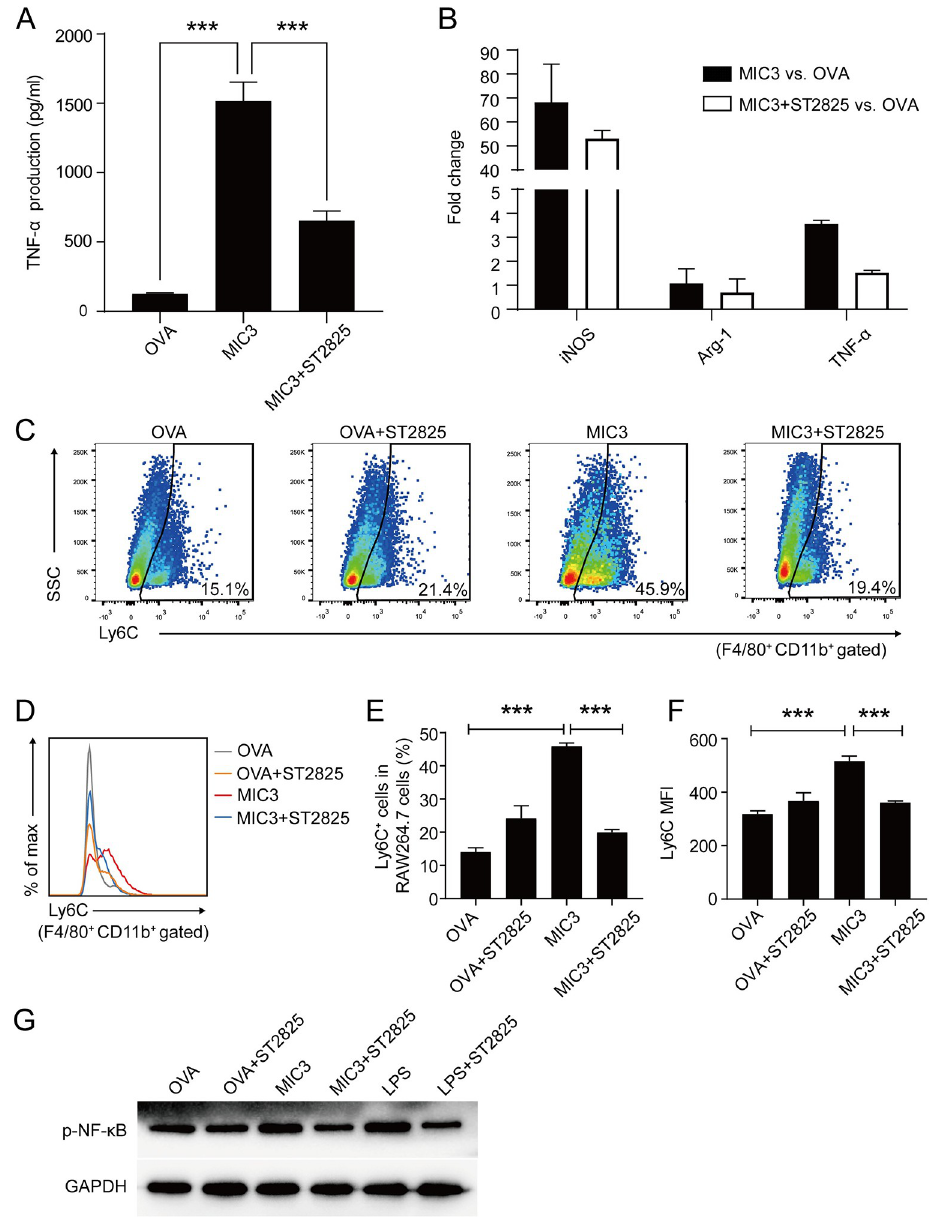
Fig 3. The role of MyD88 in inflammatory immune response induced by MIC3 in RAW264.7 cells. (A) The levels of TNF- α secreted by RAW264.7 cells after 24 h-treatment of 4 μ g/ml MIC3 and OVA. To inhibit the activity of MyD88, RAW264.7 cells in group MIC3+ST2825 were preincubated with 20 μ g/ml MyD88 inhibitor ST2825 for 3 h. The secretion of TNF- α was analyzed by ELISA. Each bar indicates the mean value ± S.D. (n = 4 independent replicates). Significance was analyzed using one-way ANOVA. ��� , P < 0.001. (B) The mRNA levels of Tnf- α and polarization-related genes after the pretreatment of MyD88 inhibitor ST2825 and 24 h-treatment of MIC3 in RAW264.7 cells. Data are expressed as the means ± S.D. (n = 4 independent replicates). 1 = no change. (C) Ly6C expression in MyD88-inhibited RAW264.7 cells. Ly6C expression in RAW264.7 cells preincubated with 20 μ g/ml MyD88 inhibitor ST2825 and treated with 4 μ g/ml OVA and 4 μ g/ml MIC3 were evaluated by flow cytometry. One representative of three independent experiments is shown. (D) Overlay of representative histograms showing Ly6C expression in MyD88-inhibited RAW264.7 cells treated with 4 μ g/ml OVA and 4 μ g/ml MIC3. (E) The percentage of Ly6C + cells in F4/80 + CD11b + gated RAW264.7 cells. Data are expressed as the means ± S.D. (n = 3 independent experiments). Significance was analyzed using one-way ANOVA. ��� , P < 0.001. (F) The MFI of Ly6C expression in F4/80 + CD11b + gated RAW264.7 cells. Each bar indicates the mean value ± S.D. (n = 3 independent experiments). Significance was analyzed using one-way ANOVA. ��� , P < 0.001. (G) The effects of MyD88 inhibitor ST2825 on